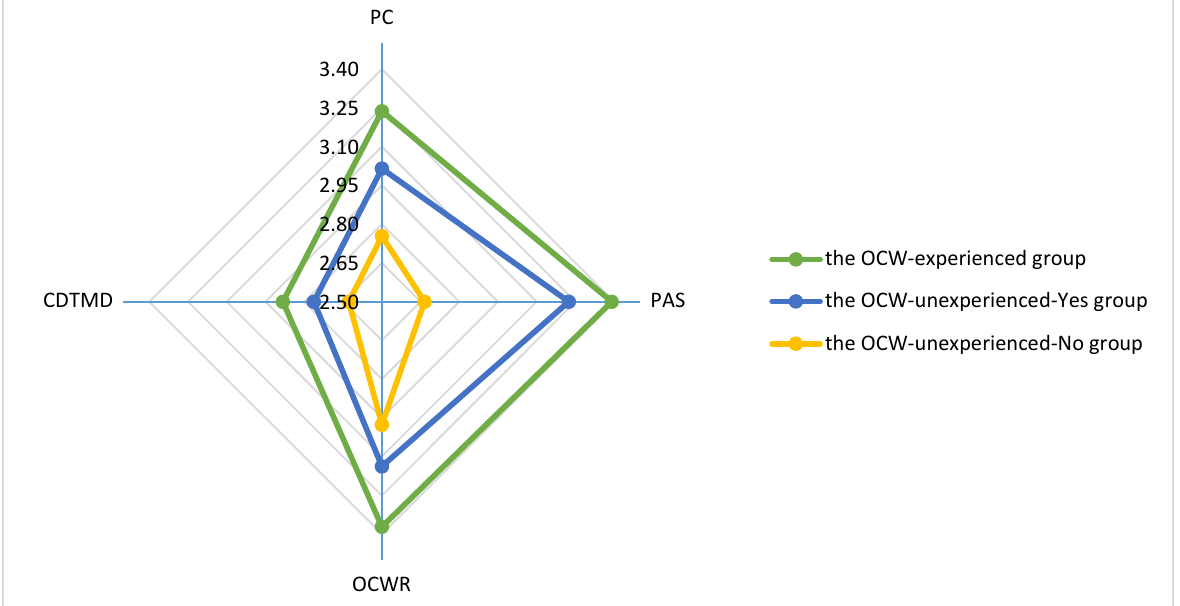
Note . OCW = OpenCourseWare; PC = personal characteristics; PAS = perception of administrative support; OCWR = OpenCourseWare recognition; CDTMD = competency in digital teaching material